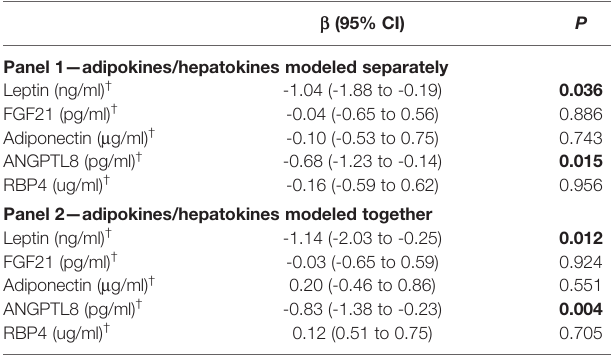
TABLE 2 | Associations of adipokines/hepatokines with LVMI in multivariate linear regression.